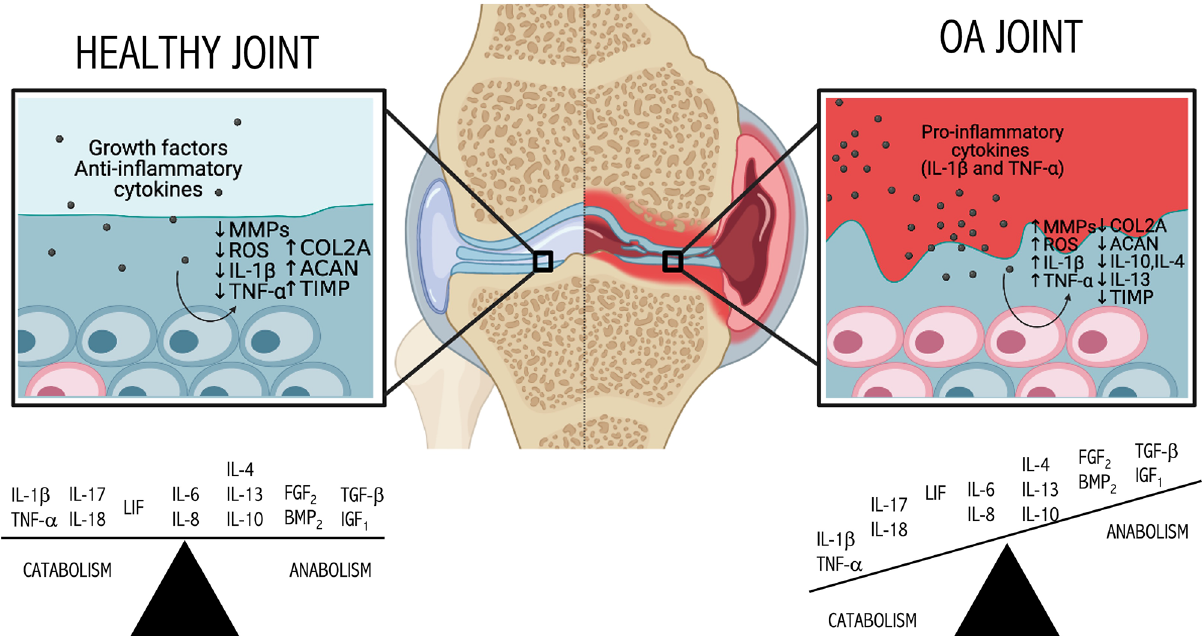
Figure 1. Involvement of regulatory proteins in chondrocyte and articular cartilage metabolism and homeostasis. In a healthy state, the predominant proteins are those that have a pro-anabolic nature, whereas for different reasons, when OA starts, pro-inflammatory cytokines increase and disrupt the balance between catabolic and anabolic molecules. In healthy articular cartilage (AC), chondrocytes remain in a quiescent state with very low turnover, and a balance between anabolic and catabolic cell processes is reached. In contrast, in OA, chondrocytes become dysregulated and start proliferating, increasing the production of inflammatory mediators and matrix-degrading enzymes, which causes mechanical weakness. Then, the basal activity of chondrocytes shifts into a more catabolic phenotype, and articular cartilage degrades as chondrocytes lose their ability to repair any damage in the surrounding extracellular matrix. Created with BioRender.com